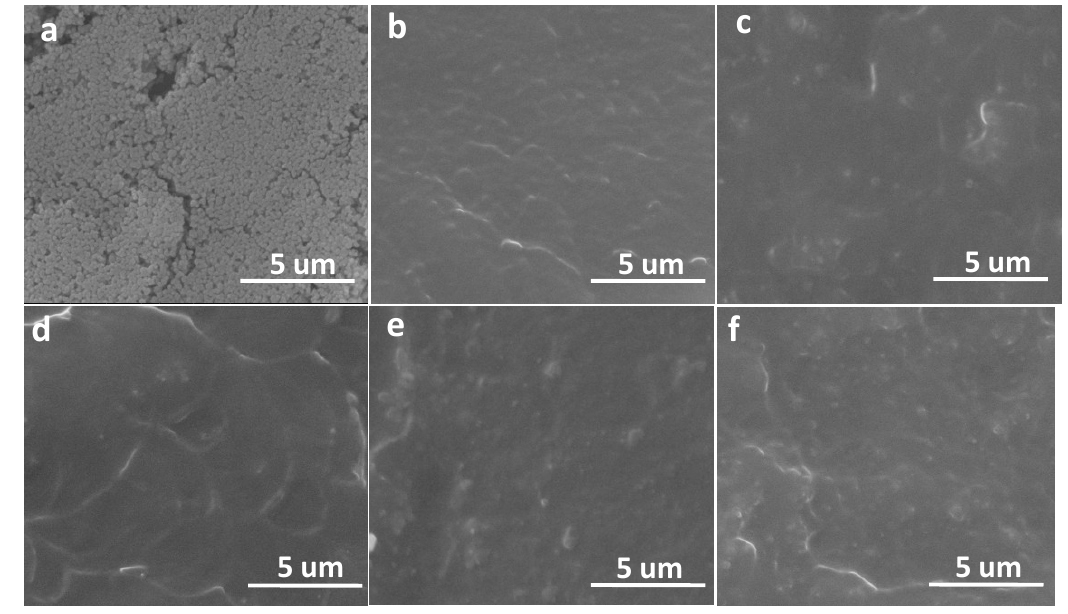
Figure 5. SEM micrographs of ( a ) silica nanoparticles and the fracture surfaces of ( b ) blank samples and the xLCNs/SiO composites (xLCN/SNP) composites with ( c ) 1%; 2 ( d ) 3%; ( e ) 5%; ( f ) 7%